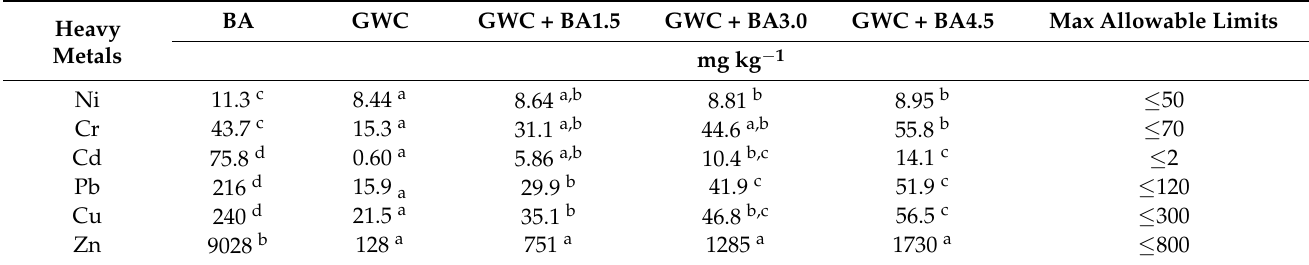
a,b,c,d,e The difference between the values with the same letter ( a,b,c,d,e ) was not statistically significant between the different materials when p < 0.05. Max allowable limits in composts (mg kg − 1 ) in Lithuania [34] are shown in the last column. BA—biofuel ash; GWC—green